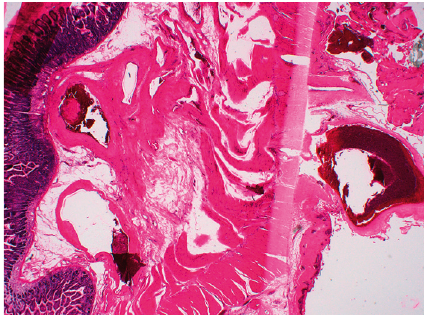
Figure 6: Histological examination of the resected part of the